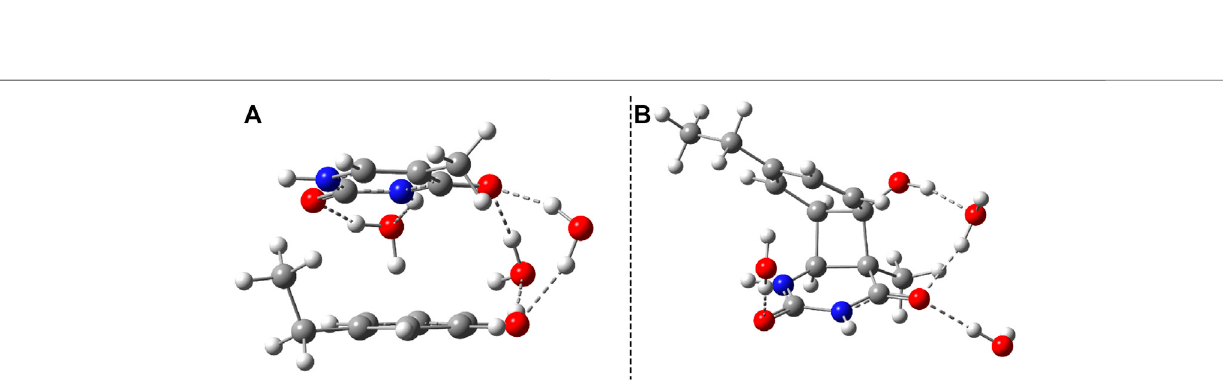
Frontiers in Bioengineering and Biotechnology |